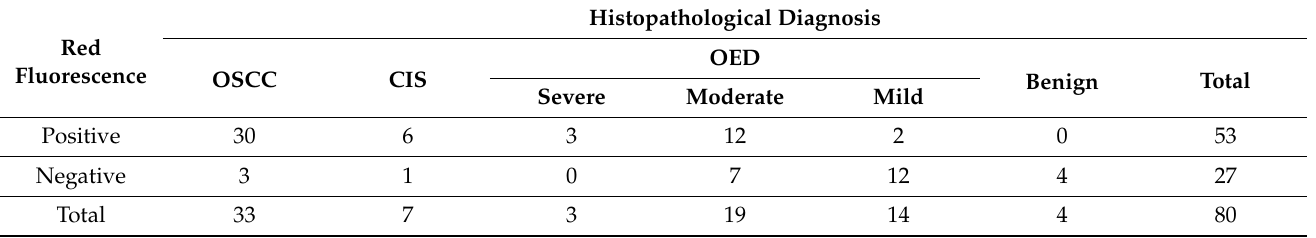
Table 2. Red fluorescence regarding histopathological diagnosis.